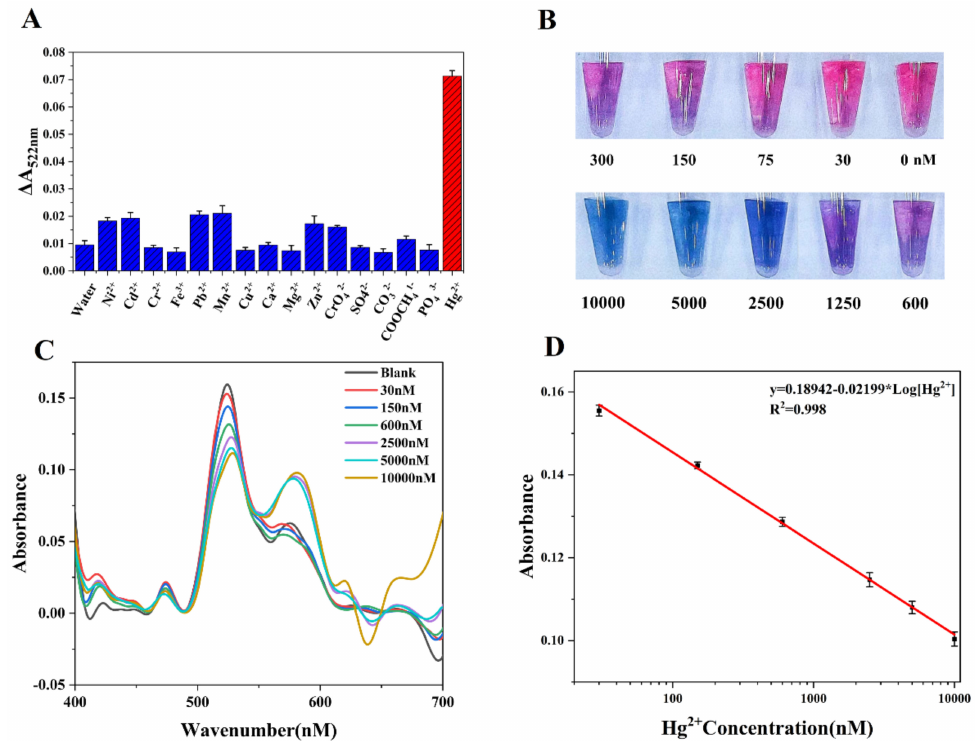
Figure 5. ( A ) Absorbance at 522 nm of AuNPs − GSH solutions when mixed with 16 different metal ions; ( B ) color changes caused by the addition of different concentrations of Hg 2+ to the AuNPs − GSH solution; ( C ) absorption spectra of the solution in ( B ) when detected by the proposed sensor; ( D ) linear relationship between absorbance at 522 nm and the Hg 2+